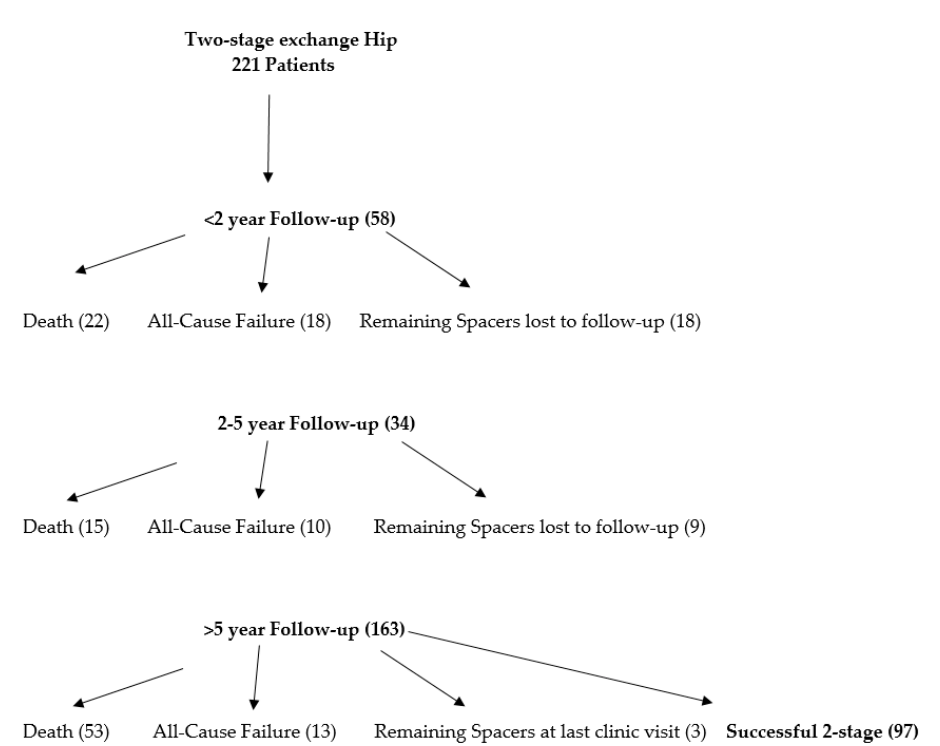
Figure 1. Patient flowchart.